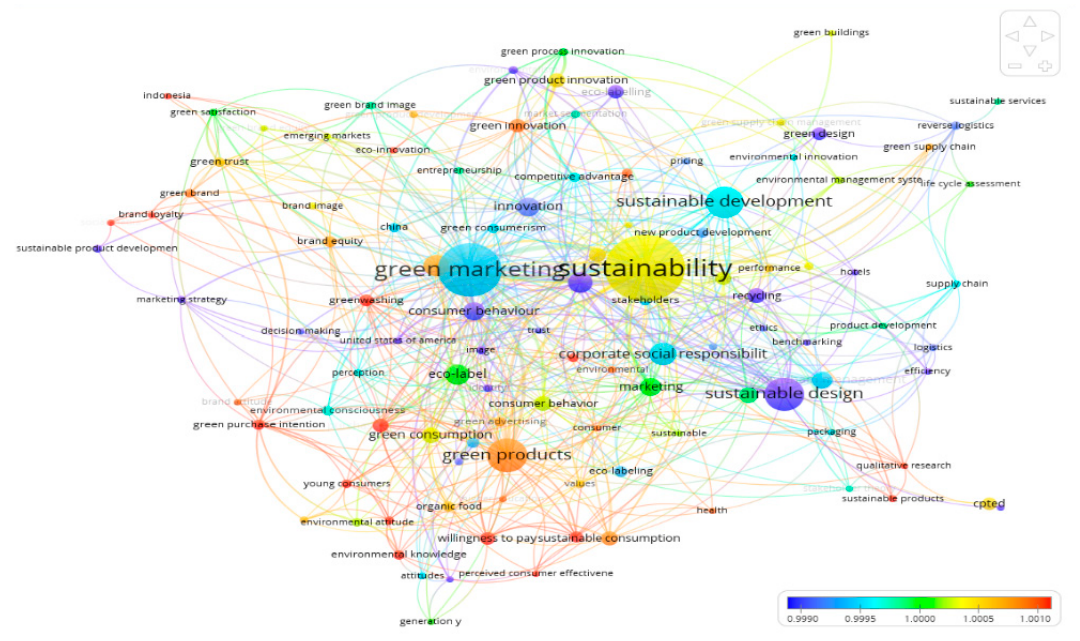
Figure 7. Network diagram based on the mean value of co-occurrence of keywords.